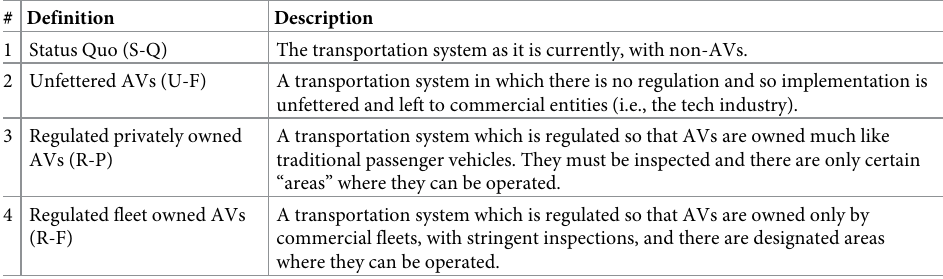
Table 2. Operational scenarios and regulatory environments